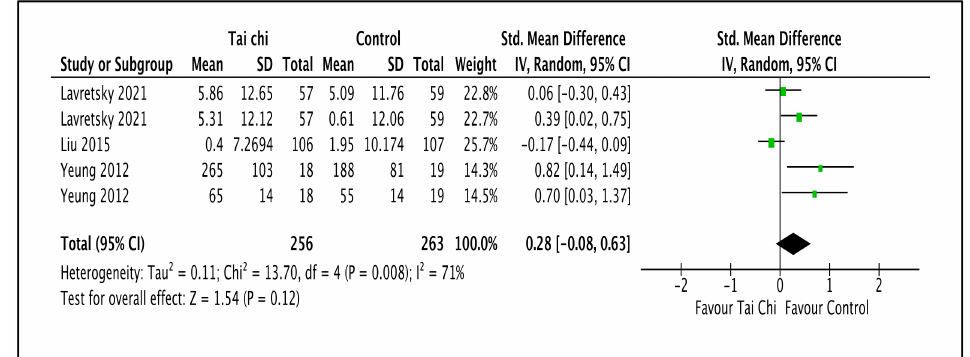
Figure 6. Forest plot shown for comparison of the combinations of Tai Chi and antidepressants versus standard antidepressants for mental-health-related QOL outcome [45,49,50]. Note: Line indicates confidence interval and the green square indicates effect estimate. Black diamond indicates cumulative effect and its confidence interval.